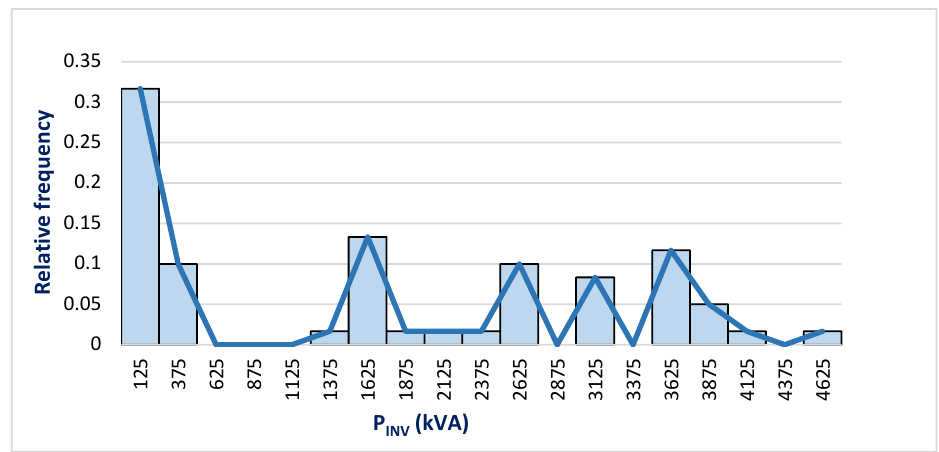
Figure 11. Histogram of the index 𝜂𝜂 For the characterization of the inverters, the (kVA) index is defined, which rep- resents the nominal power installed in the inverters of each PV plant. The results obtained for this indicator show great variability (Figure 12), which is because the indicator depends on the design strategies, establishing an inversely proportional relationship between the number of inverters and their installed power. The results show that the nominal power range of the inverters is between 100 and 4800 kVA. However, it is verified that the most frequent classes for P INV are 0–500 kVA, 1500–1750 kVA and 3500–3750 kVA, with 41.66%, 13.33% and 11.66% of the cases, respectively. For the rest of the indicator values, the relative frequency does not exceed 10% in any case.